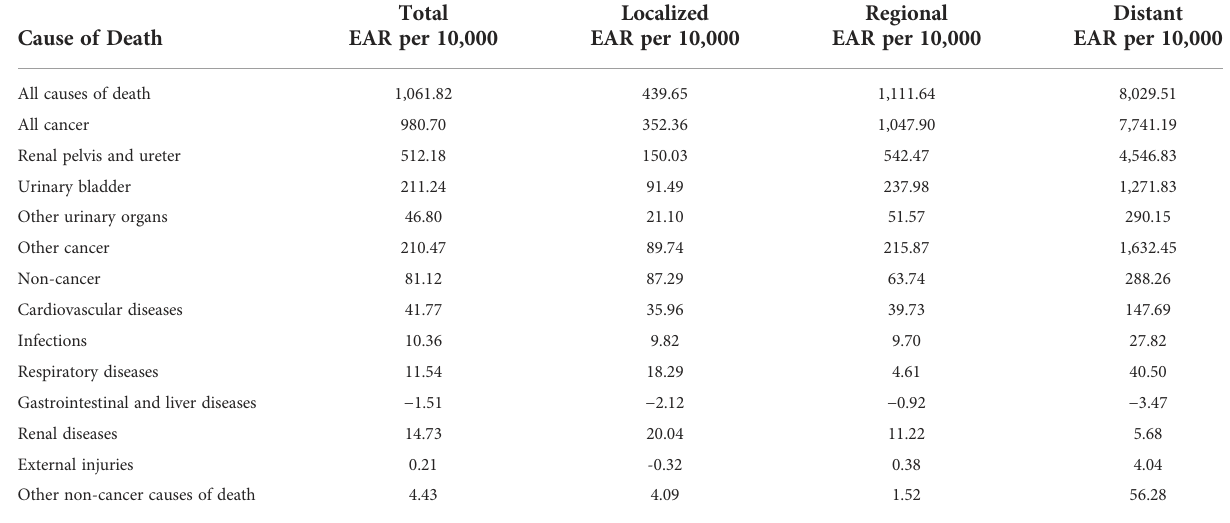
TABLE 3 Excess absolute risks for patients with UTUC.